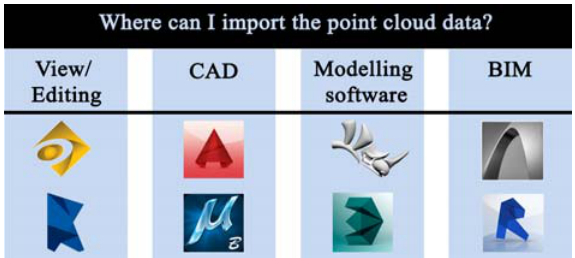
Figure 4. A “simple” geometrical object, where the vertical sections to be interpreted are at least